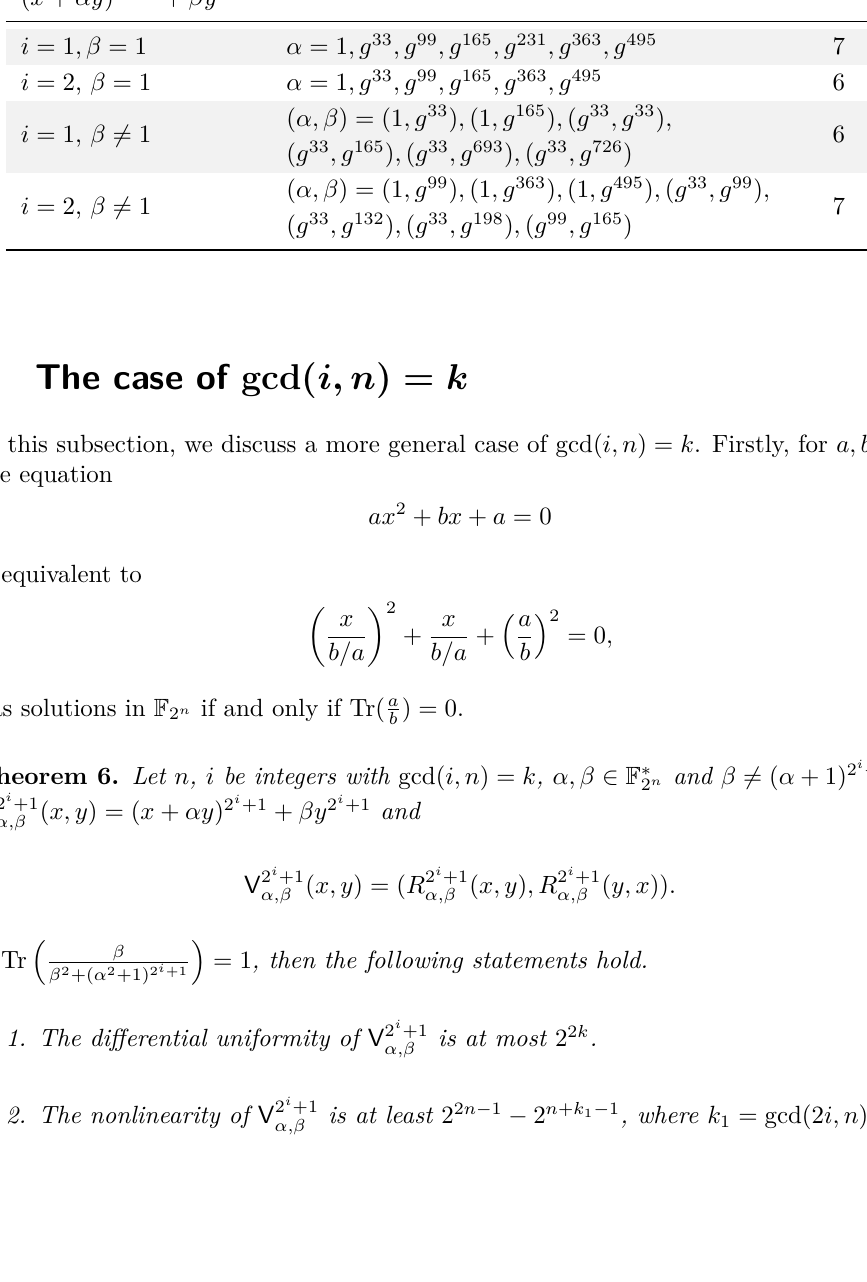
Table 1: CCZ-inequivalence functions/permutations over F 2